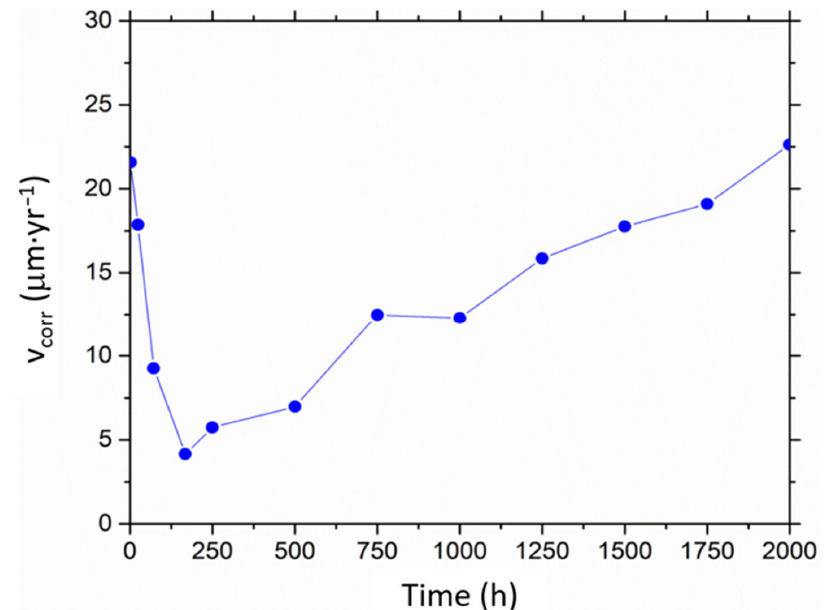
Figure 9. Corrosion rates estimated by EIS in coated P91.